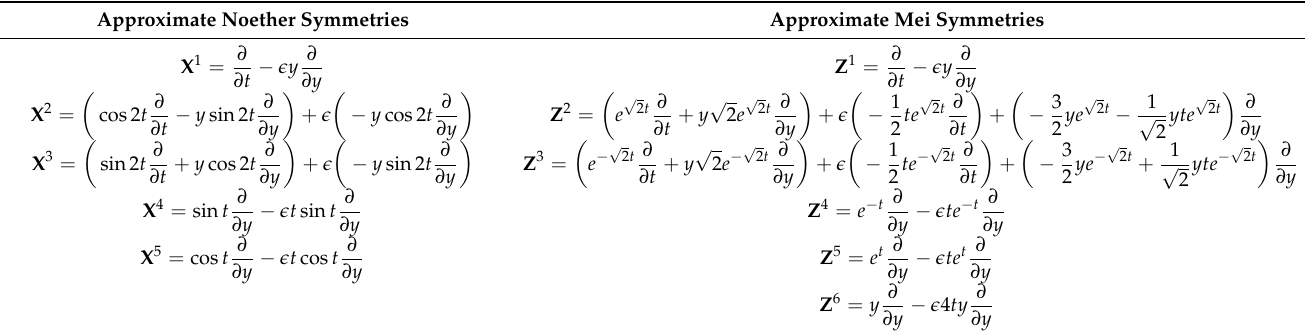
Table 1. Comparison between approximate Noether symmetries and approximate Mei symmetries for DHO. Approximate Noether Symmetries Approximate Mei